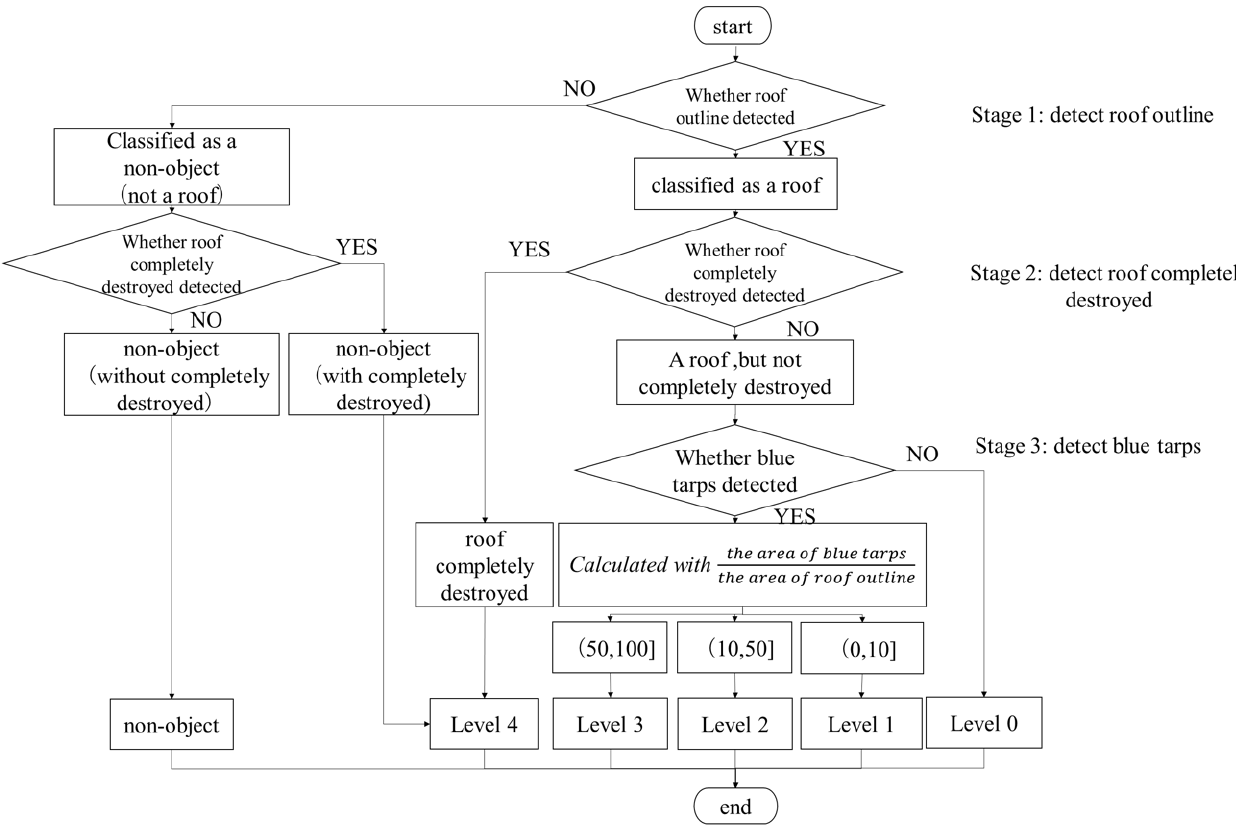
Figure 14. Flowchart of classification of the level of roof damage.